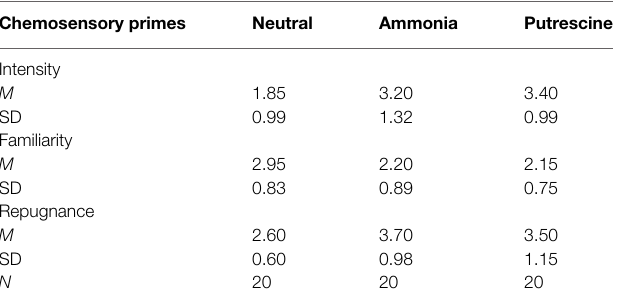
TABLE 4 | Scent ratings for the chemosensory primes (Experiment 3).